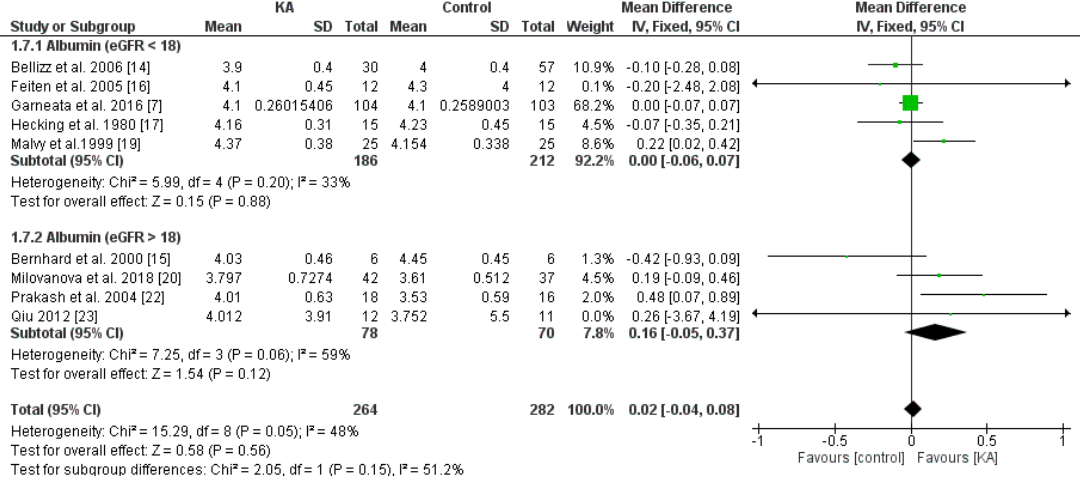
Figure 6. Forest plot of effects of KA on BUN in CKD patients sub-grouped by eGFR. The random- effects model was utilized.